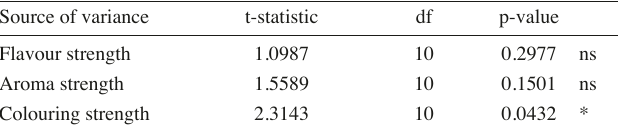
Tab. 2: The means of the two groups (saffron collected in bud and blos - somed) are compared and considered significantly: *, p <0.05; ns, not significantly